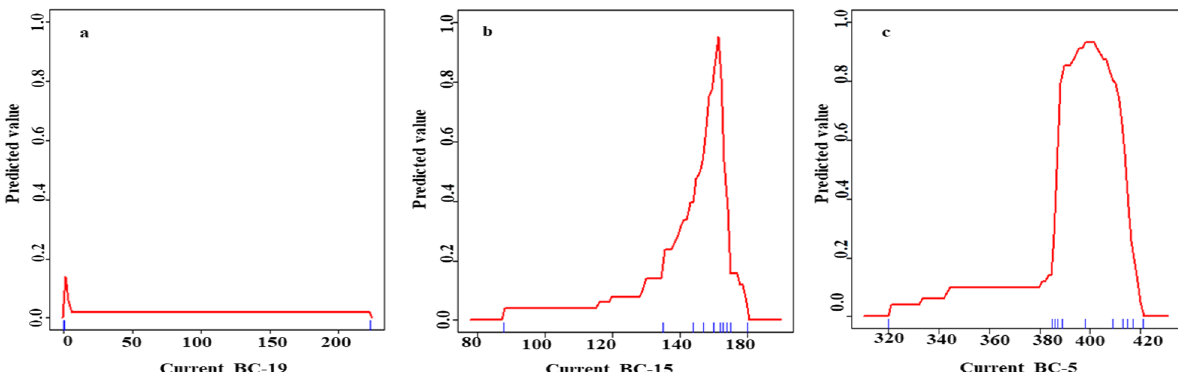
Fig. 4 Receiver operating characteristics curve (ROC) illustrating relationship between probability of occurrence of suitable conditions for distribution of C. wightii with most significant bioclimatic predictor during current time frame: a PrCQ, b PrS and c MaTWaM